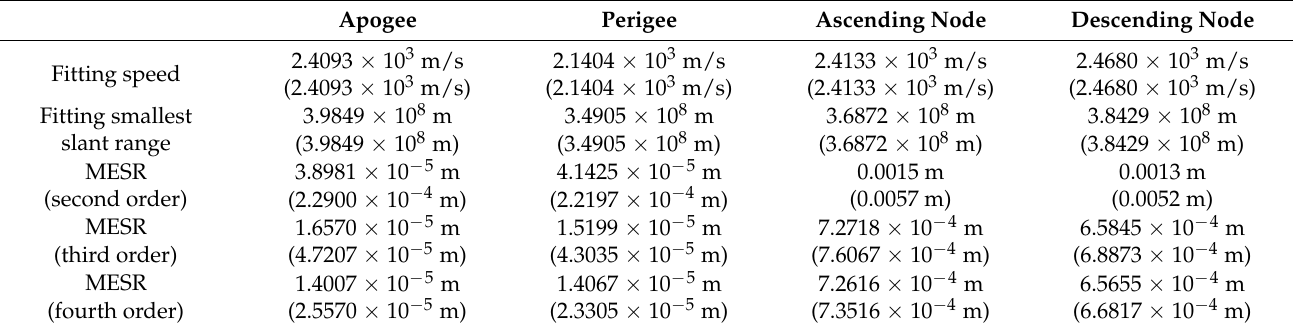
Table 4. The fitting parameters for MBS (0 ◦ , 0 ◦ ) with a look angle (left looking) about 0.1 ◦ , with the synthetic aperture time being about 80 s (contents outside brackets) and 150 s (contents inside brackets). The time of apogee, perigee, ascending, and descending nodes are consistent with the time in Tables 2 and 3.